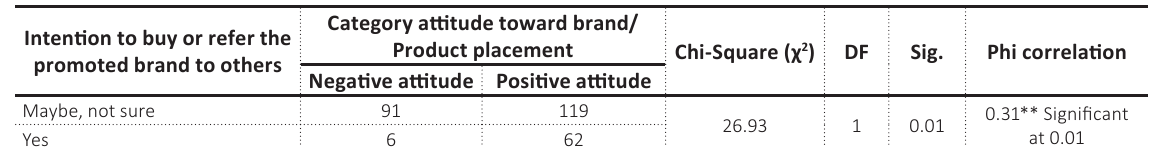
Table 6. Chi-square and phi coefficient tests for intention to buy and attitude towards brand placement in Web